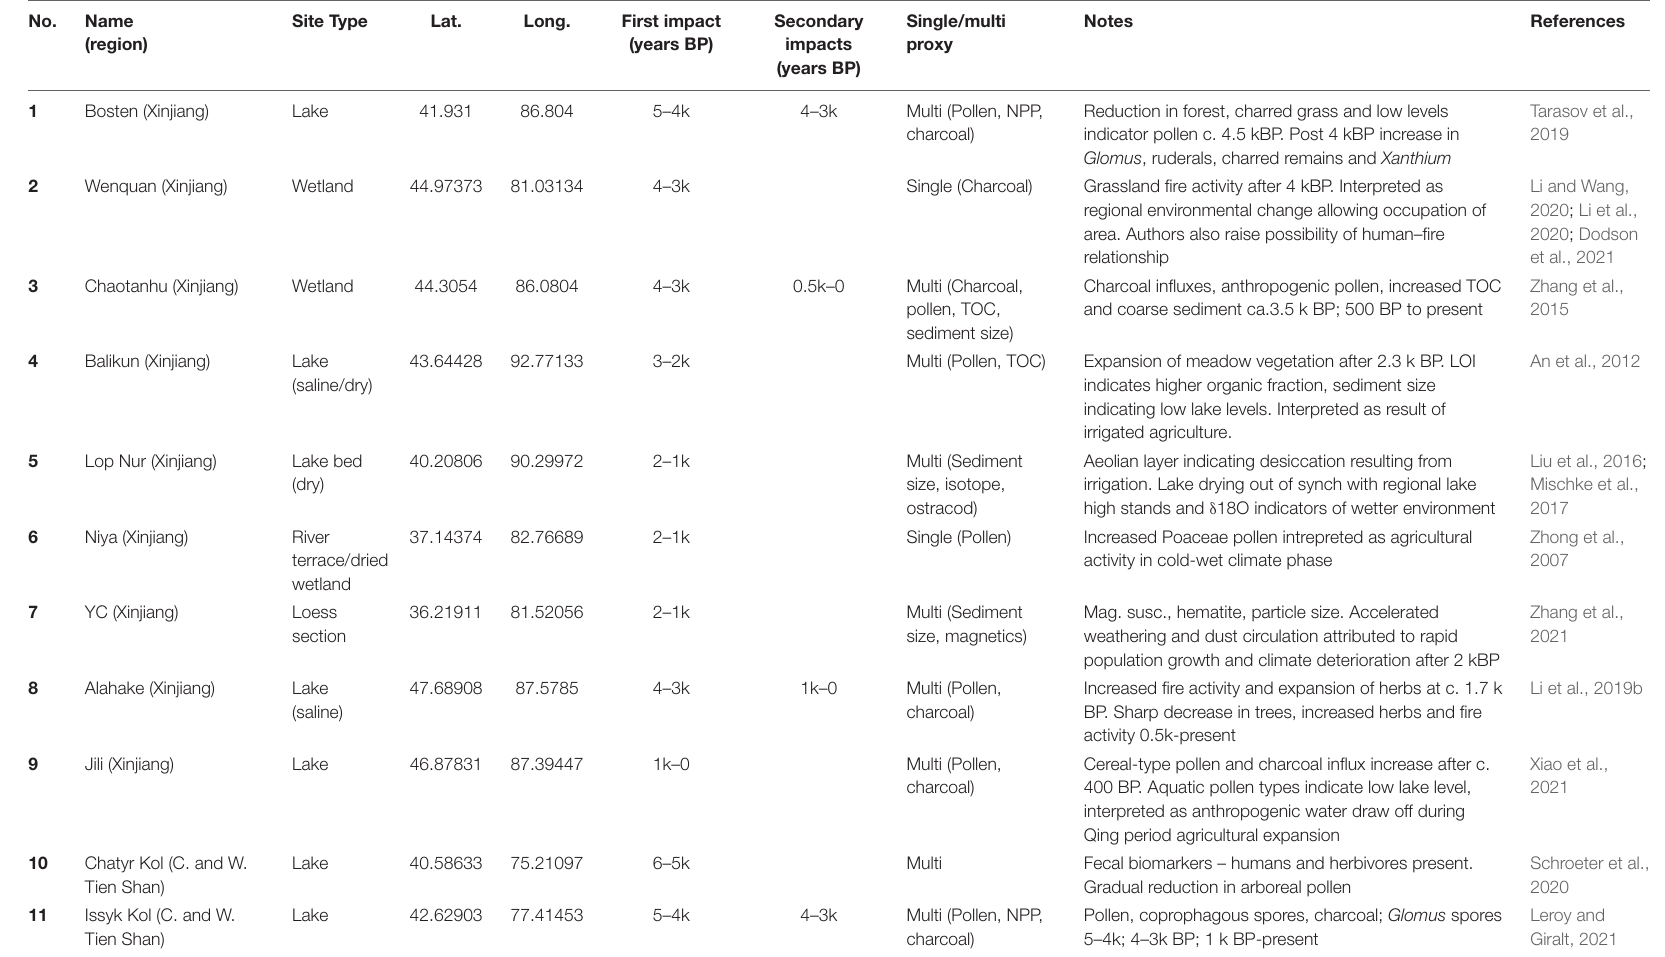
TABLE 1 | Locations, general proxy descriptions, and references for palaeoenvironmental records reviewed here.